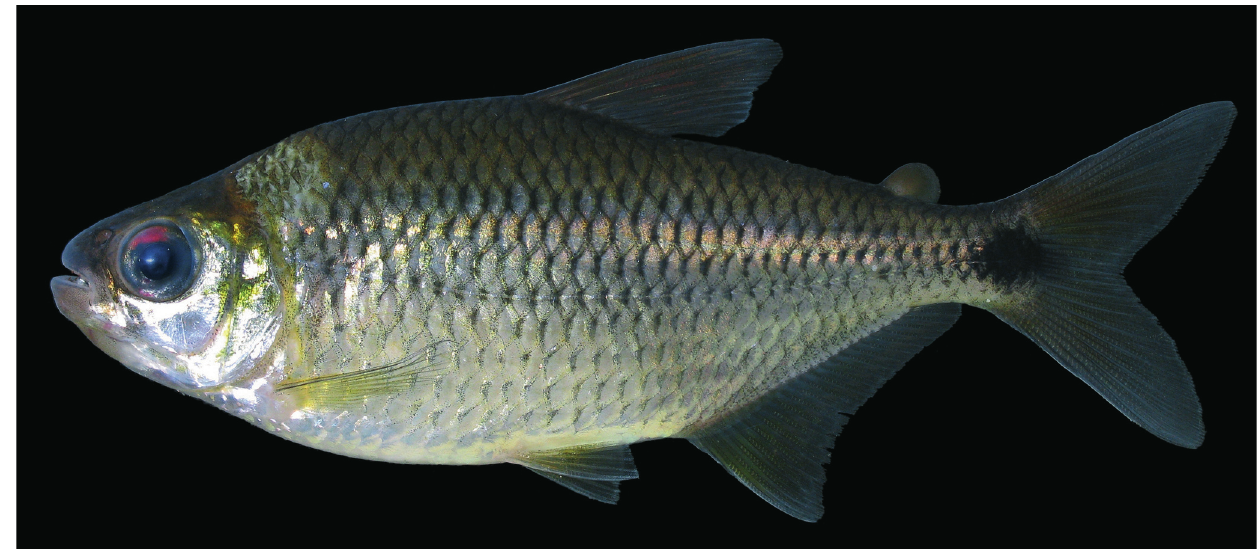
Fig. 2. Jupiaba kurua , live paratype, MZUSP 101299, approximately 80.0 mm SL, upper rio Curuá, Xingu